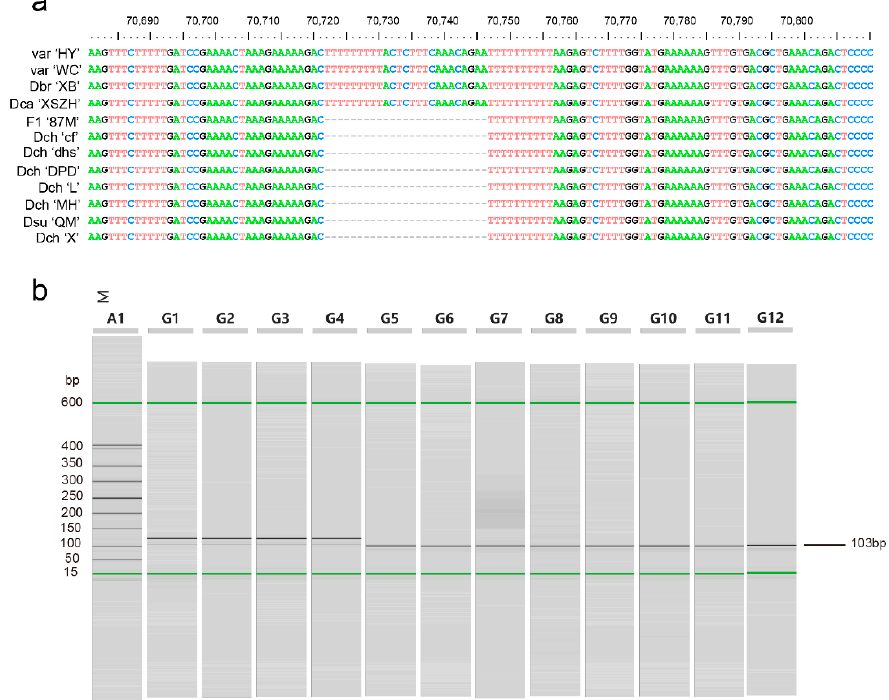
Figure 8. The capillary electrophoresis results of the amplification of DNA makers using designed primers. ( a ) Sequence alignment results at the positions of the design Maker1. ( b ) The result of Maker1. Lane M is the marker of DL400. The lanes from left to right correspond to products amplified from Dca ‘XSZH’, ‘HY’, Dbr ‘XB’, ‘WC’, Dsu ‘QM’, Dch ‘MH’, F 1 ‘87M’, Dch ‘cf’, Dch ‘dhs’, Dch ‘X’, Dch ‘L’, and Dch ‘DPD’.